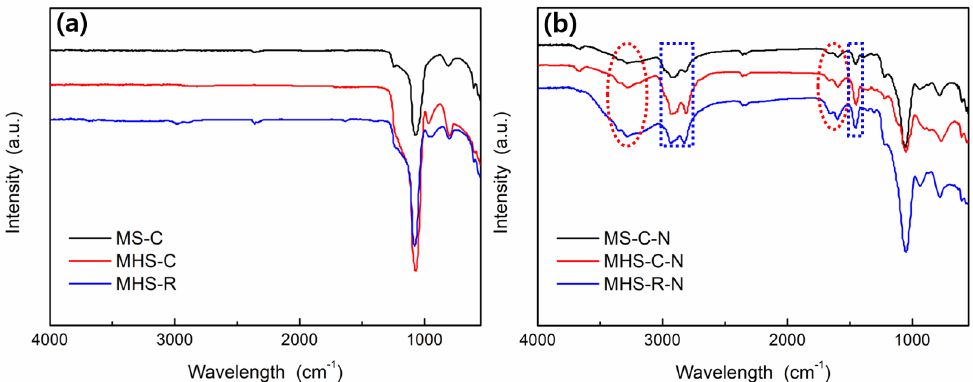
Figure 1. FT-IR spectra of mesoporous silica and mesoporous hollow silica: ( a ) Before amine func- tional group attachment; and ( b ) After amine functional group attachment.